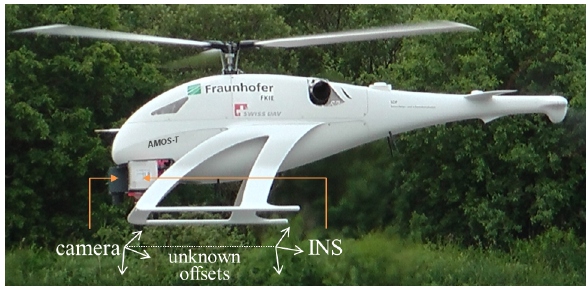
Figure 1: The calibration of the static coordinate system offsets between a camera and an INS enables the direct georeferencing of images collected with small